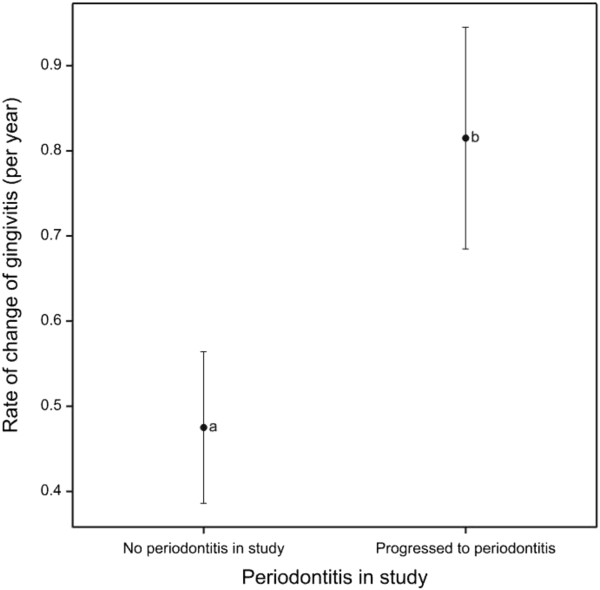
Gingivitis score progression rate according to periodontitis progression. Mean rate of gingivitis score progression per year in periodontitis affected aspects compared to aspects with no periodontitis progression, with 95% confidence intervals.